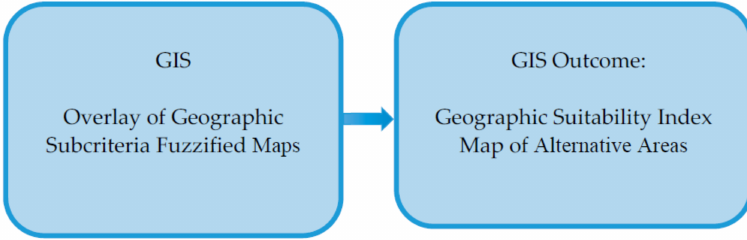
Figure 1. Geographic information systems (GIS)